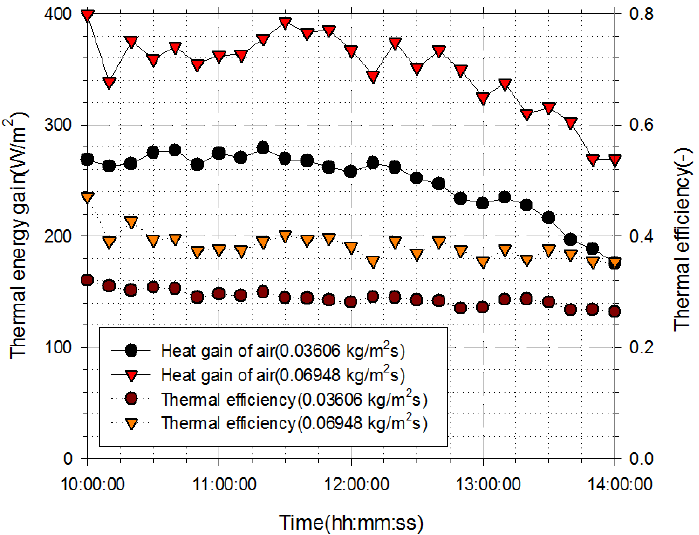
Figure 9. Thermal energy gain and thermal efficiency of the PVT air collector with operating time.